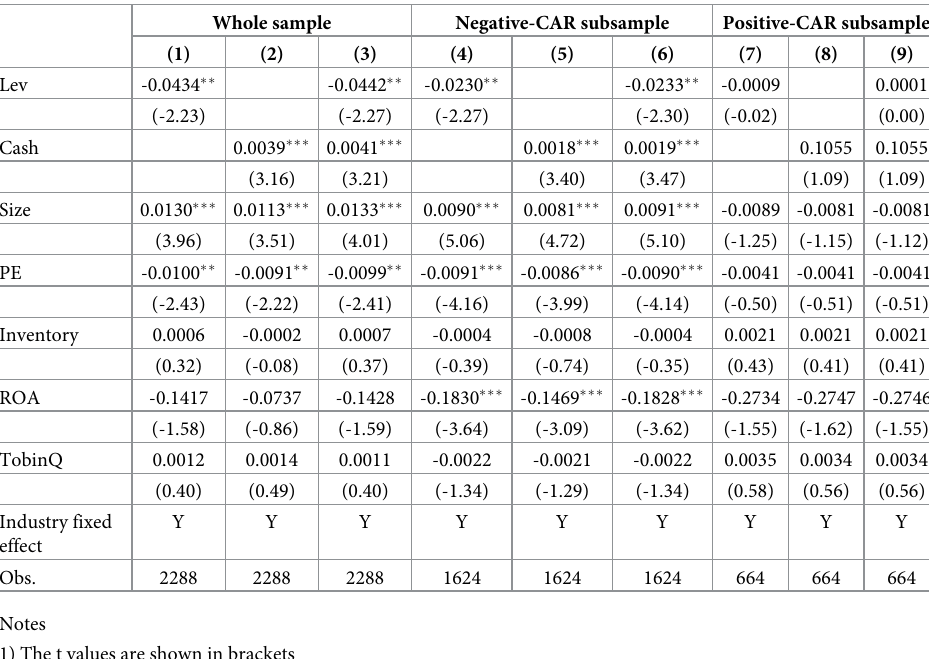
Table 6. Baseline regression results.